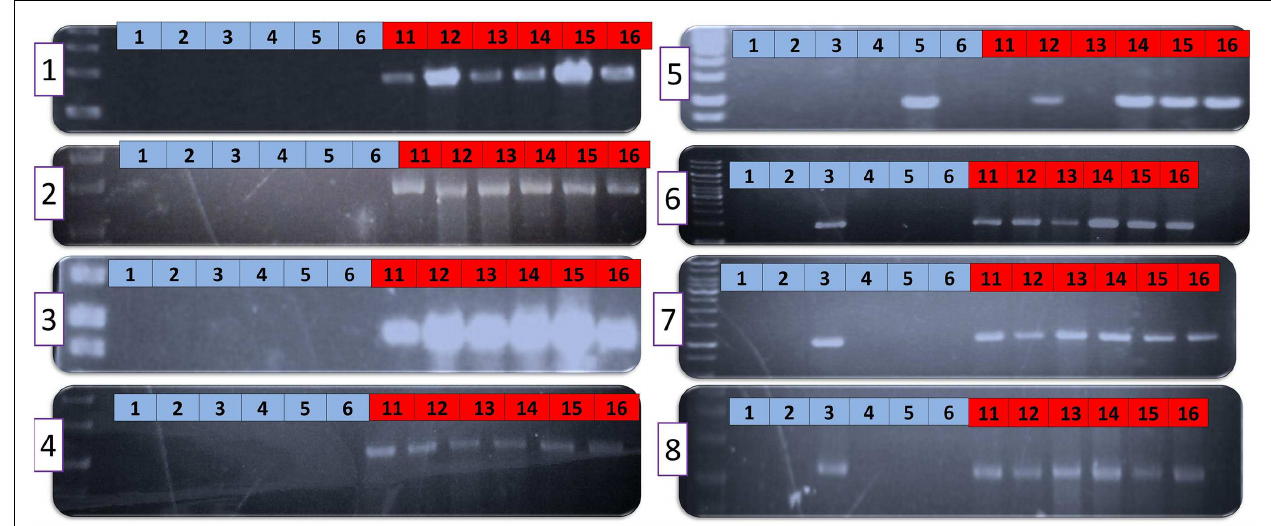
FIGURE 2 | PCR with primers targeting the eight FA fragments of selected groups I and II Acidovorax citrulli strains. Numbers (1–8) inside purple-outlined boxes at the left of each gel represent the FA number. Blue and red boxes at the top of each gel correspond to DNA from groups I and II strains, respectively. Group I strains: 1, AAC98-17; 2, AAC200-23; 3, AACAU-9; 4, AAC200-30; 5, AAC92-305; 6, M6. Group II strains: 11, AAC94-48; 12, AAC201-20; 13, AAC94-55; 14, AAC202-69; 15, AAC94-87; 16, AAC201-19. Strain details are provided in Table 2